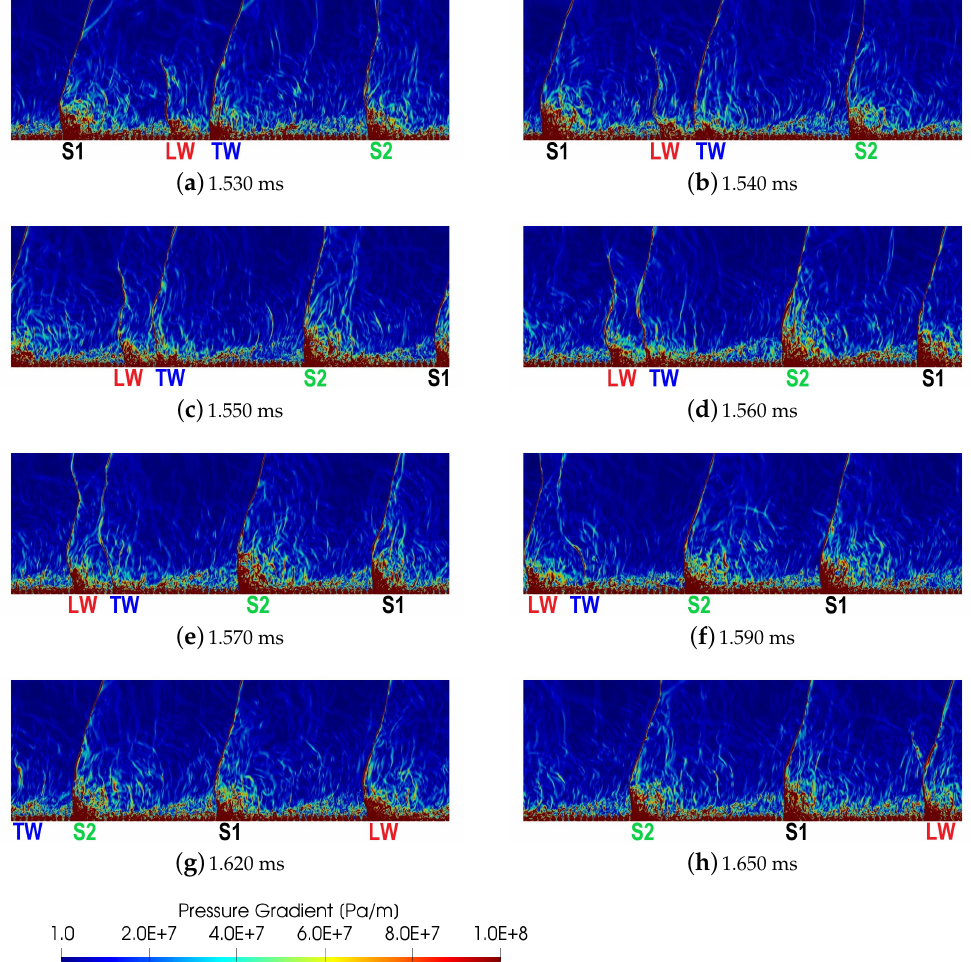
Figure 11. Unwrapped 2D projection of the RDRE chamber centerline showing spatial pressure gradients during the four to three wave DMT from 1.530 ms to 1.650